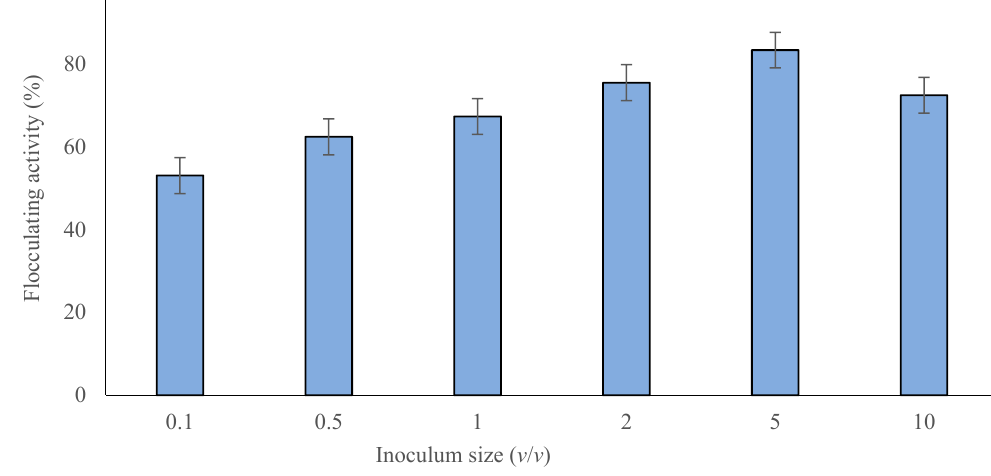
Figure 2. Effect of inoculum size on bioflocculant production.